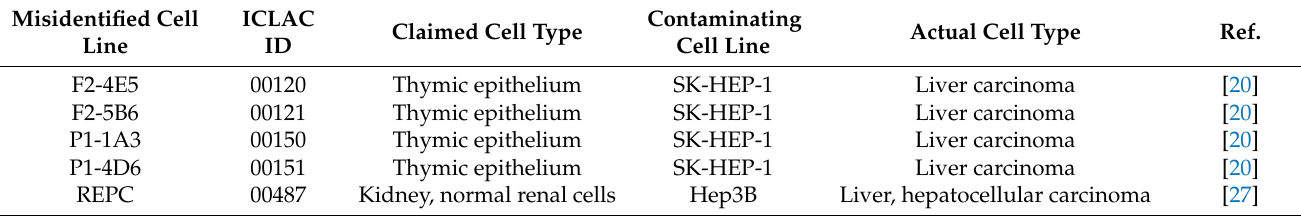
Table 2. Selection of cell lines contaminated with human liver cells